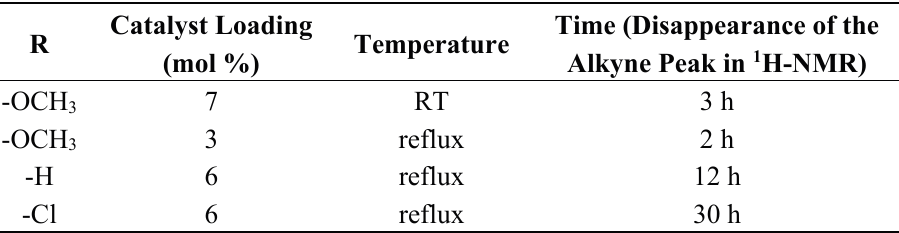
Table 1. Enyne Metathesis